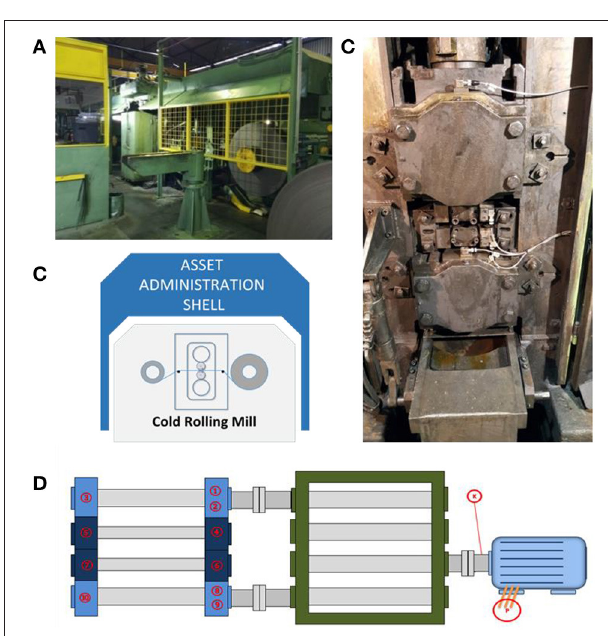
FIGURE 6 | The milling station: (A) an overview; (B) a representation of the asset in the AAS; (C) the rolls when the main casing is open and the placement of sensors; (D) the sensors placement in the infrastructure